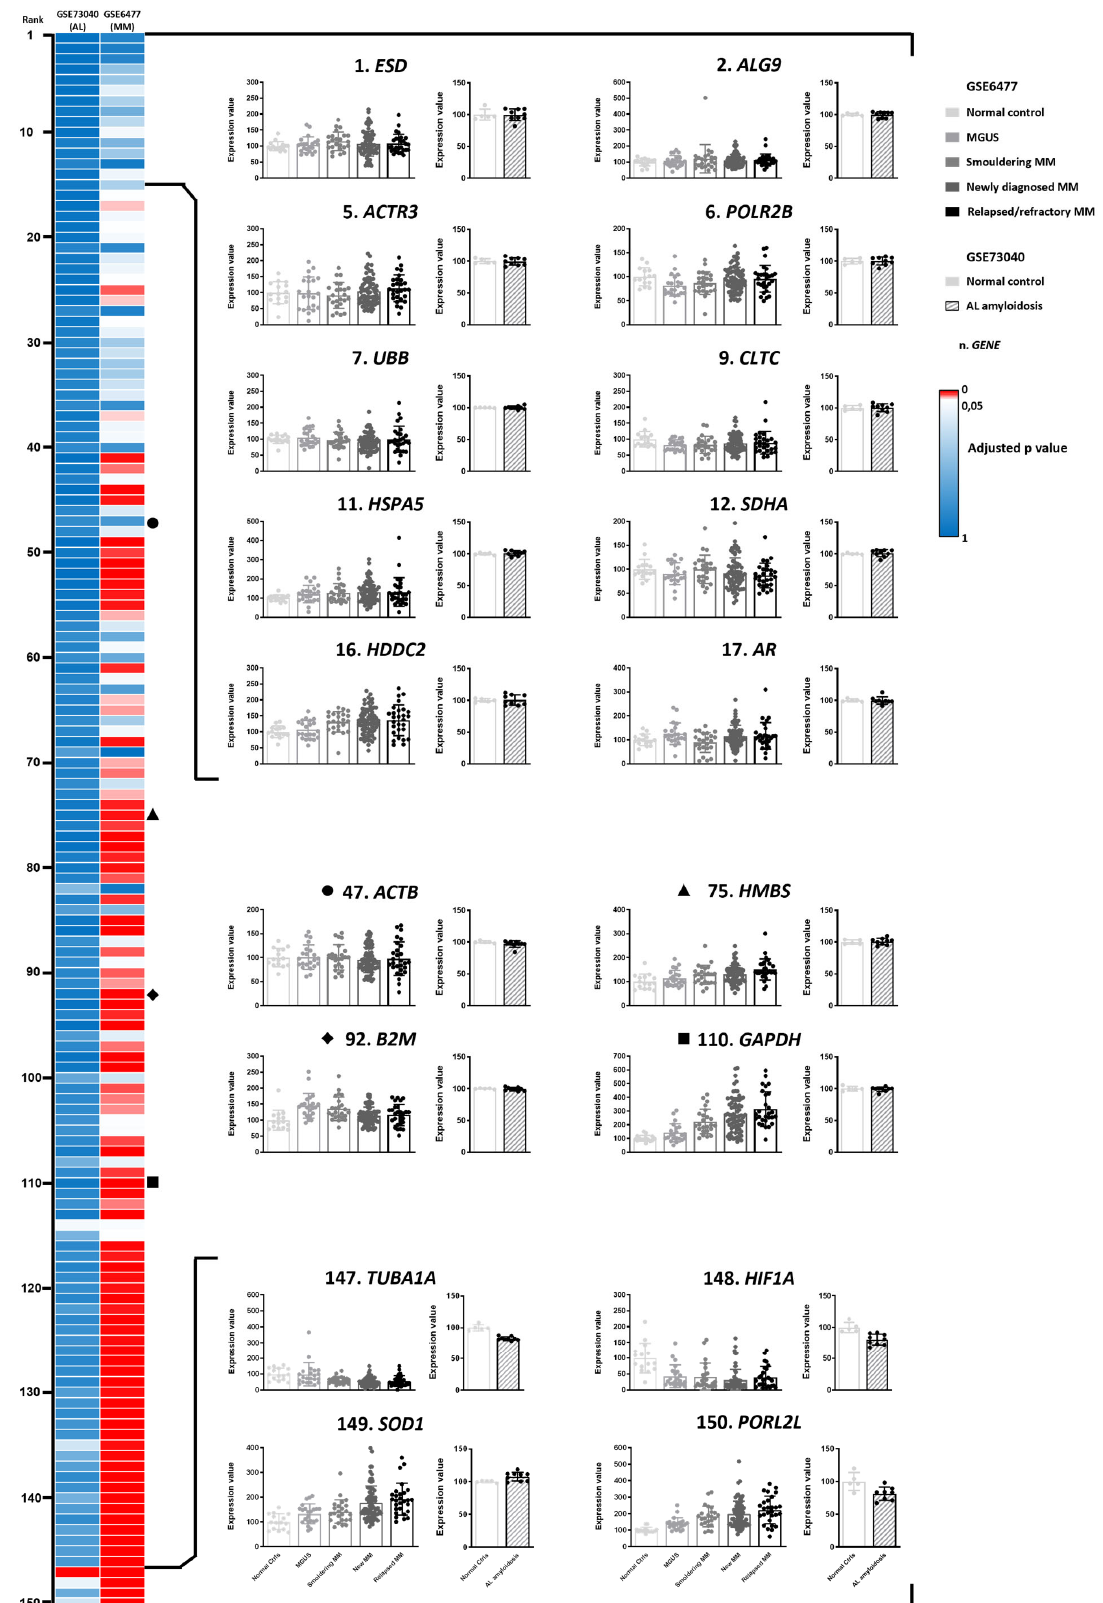
Figure 1. Evaluation of the expression stability of candidate reference genes based on publicly available transcriptomic datasets. Ranking of the candidate reference genes from the systematic research based